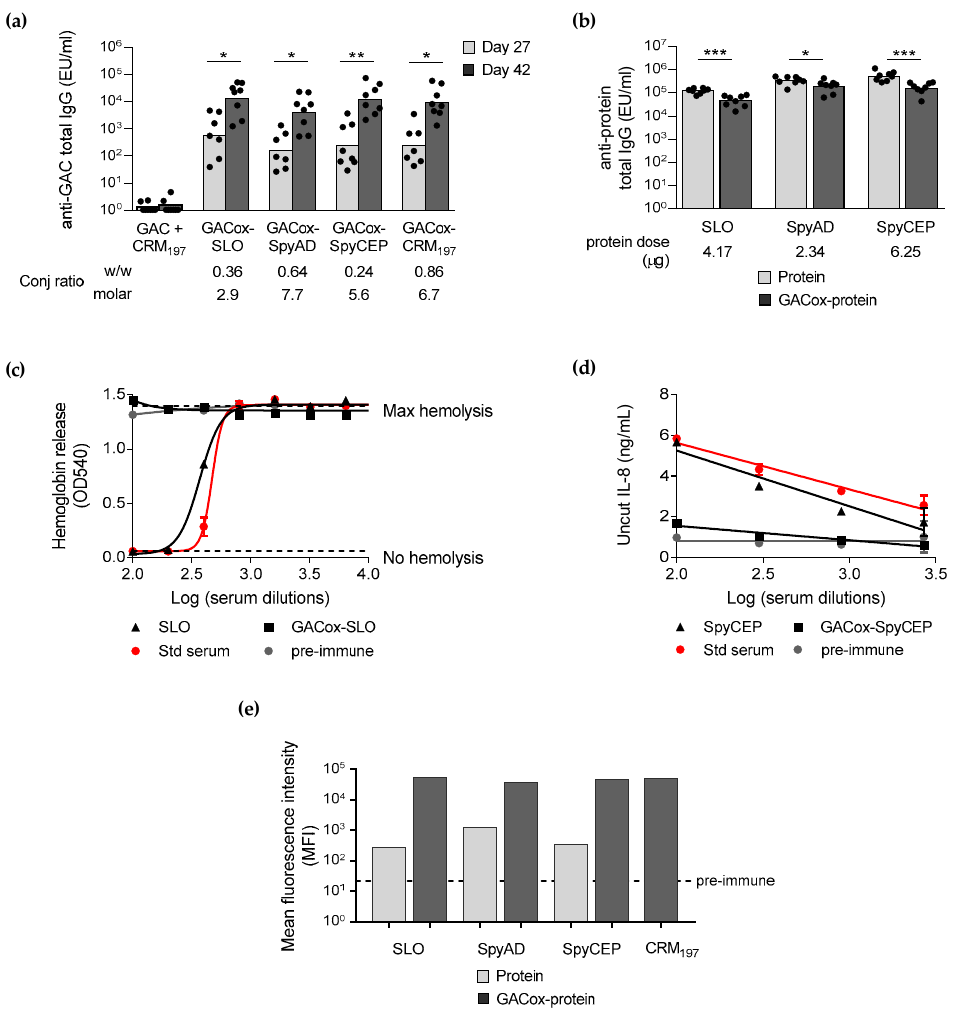
Figure 5. Immunogenicity of GAC physically mixed to CRM 197 and when conjugated to CRM 197 or GAS proteins SLO, SpyAD and SpyCEP. CD1 mice were immunized intraperitoneally (i.p.) at day 0 and 28 with 1.5 µg GAC/dose or with the corresponding dose of the carrier protein alone, all formulated with 2 mg/mL Alhydrogel. Sera were analyzed by enzyme-linked immunosorbent assay (ELISA) using as coating antigens GAC-HSA ( a ) or SLO, SpyAD and SpyCEP ( b ). Summary graphs of anti-antigen specific IgG geometric mean units (bars) and individual antibody levels (dots) are reported. Not enough sera was available for one mice of day 27 for GACox-SLO, GACox-SpyAD and GACox-CRM 197 groups. Kruskal-Wallis test was performed among the 4 groups immunized with the conjugates in graph ( a ) ( p > 0.05), Wilcoxon test was performed between response at day 27 and day 42 in graph ( a ) and Mann-Whitney two-tailed test between each group immunized with protein alone or GACox-protein conjugate in graph ( b ) (* p < 0.05, ** p < 0.01, *** p < 0.001). Sera were tested in the hemolysis inhibition assay ( c ) and in the IL-8 cleavage inhibition assay ( d ) to evaluate their ability to block native SLO and SpyCEP activity, respectively. The amount of hemoglobin released by rabbit red blood cells ( c ) and of uncut IL-8 ( d ) observed at each serum dilution tested is reported for pre-immune serum, standard serum and one selected day 42 serum for each immunization group. Each serum dilution was tested twice and the mean value with error bar was reported in the graph (for some points the error bars are not shown as shorter than the height of the symbol). Pooled sera at day 42 were tested in Flow cytometry (FACS) ( e ) to evaluate their ability to bind to GAS bacterial cells. Following incubation of bacteria with the di ff erent sera, APC-conjugated anti-mouse IgG secondary antibody was used for detection. The mean fluorescence intensity (MFI) of 10,000 acquired events, measured for each serum, is reported as compared to pre-immune sera. Results obtained with sera diluted 1:500 are reported, as representatives of the three dilutions tested (1:500, 1:5000 and